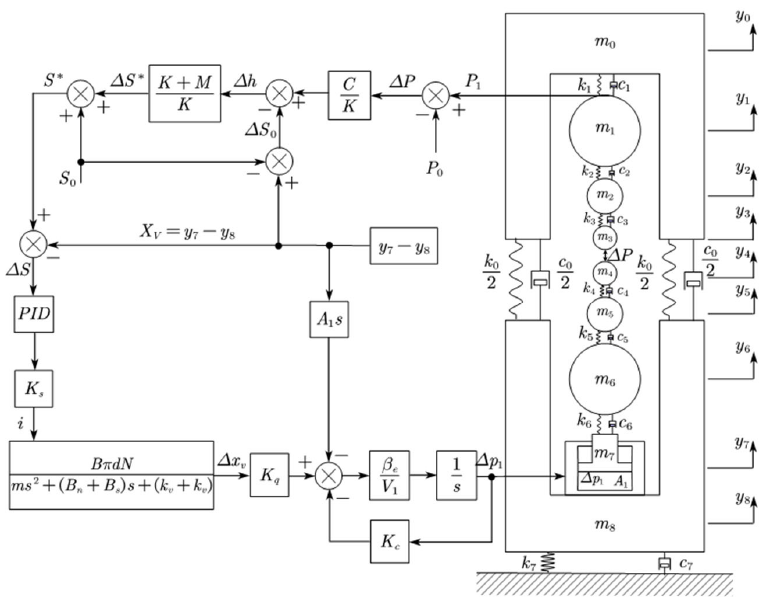
Figure 3. Mechanical hydraulic coupling vibration model of vertical system of rolling mill.